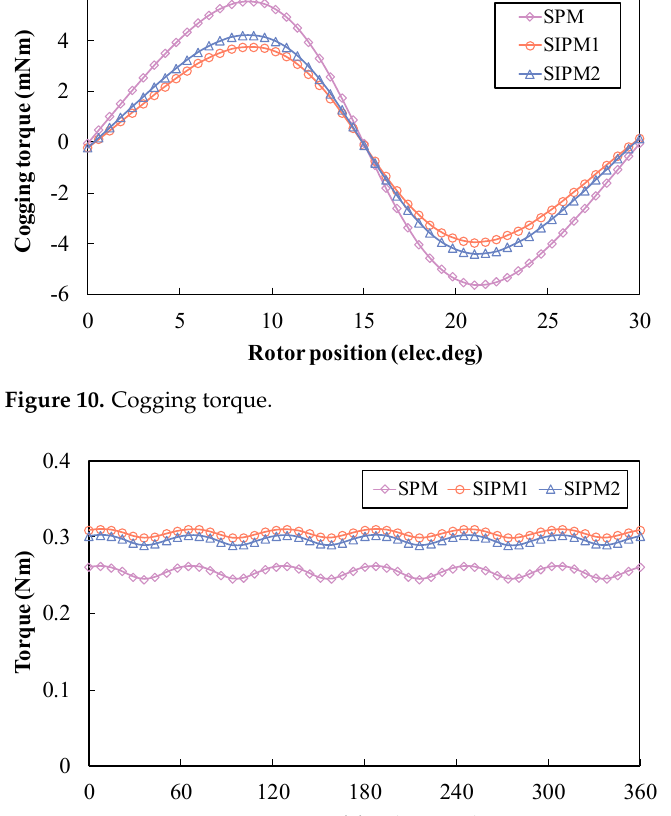
Table 4. Torque characteristic of motors.